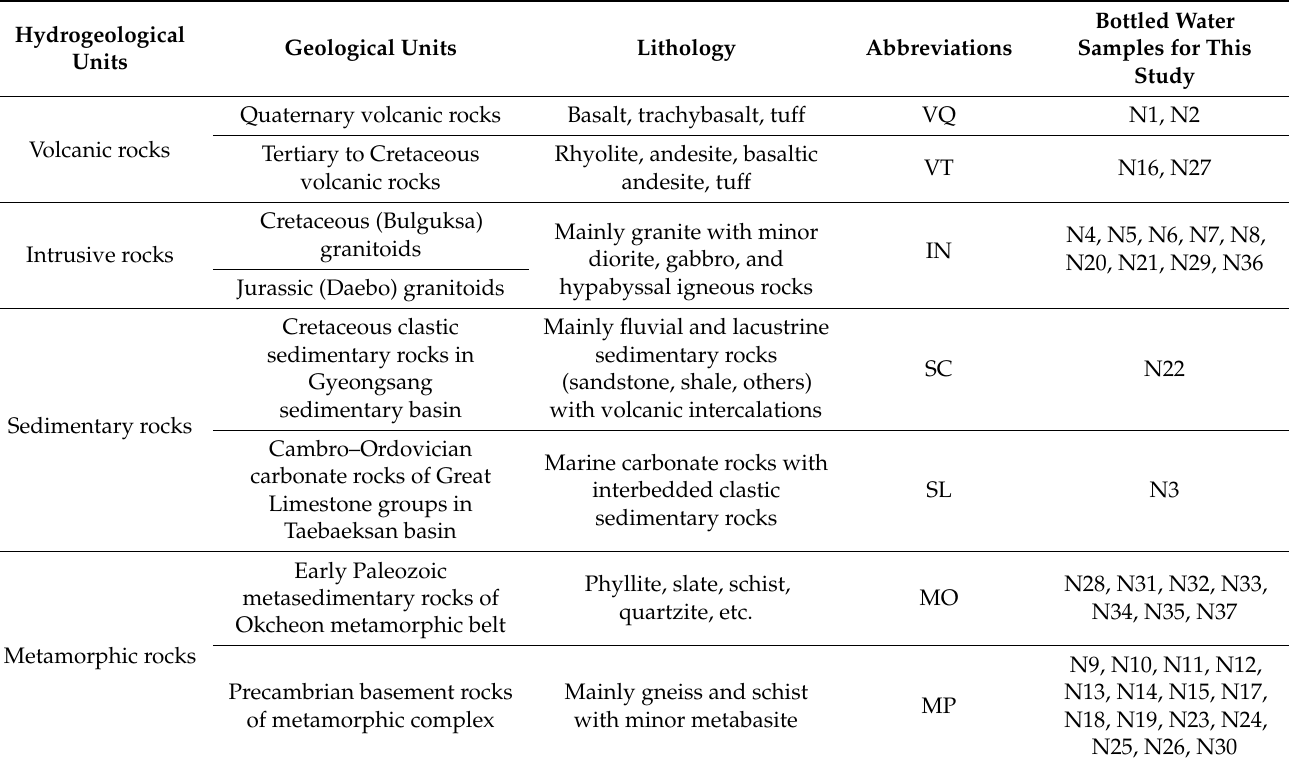
Table 1. Major geological units of bedrock aquifers in South Korea (after [53]) and the assignment of bottled mineral water samples according to the geology around